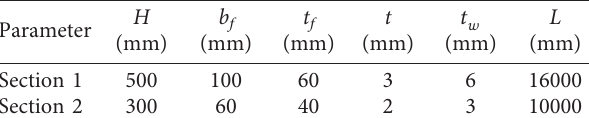
Table 7: The sizes of the